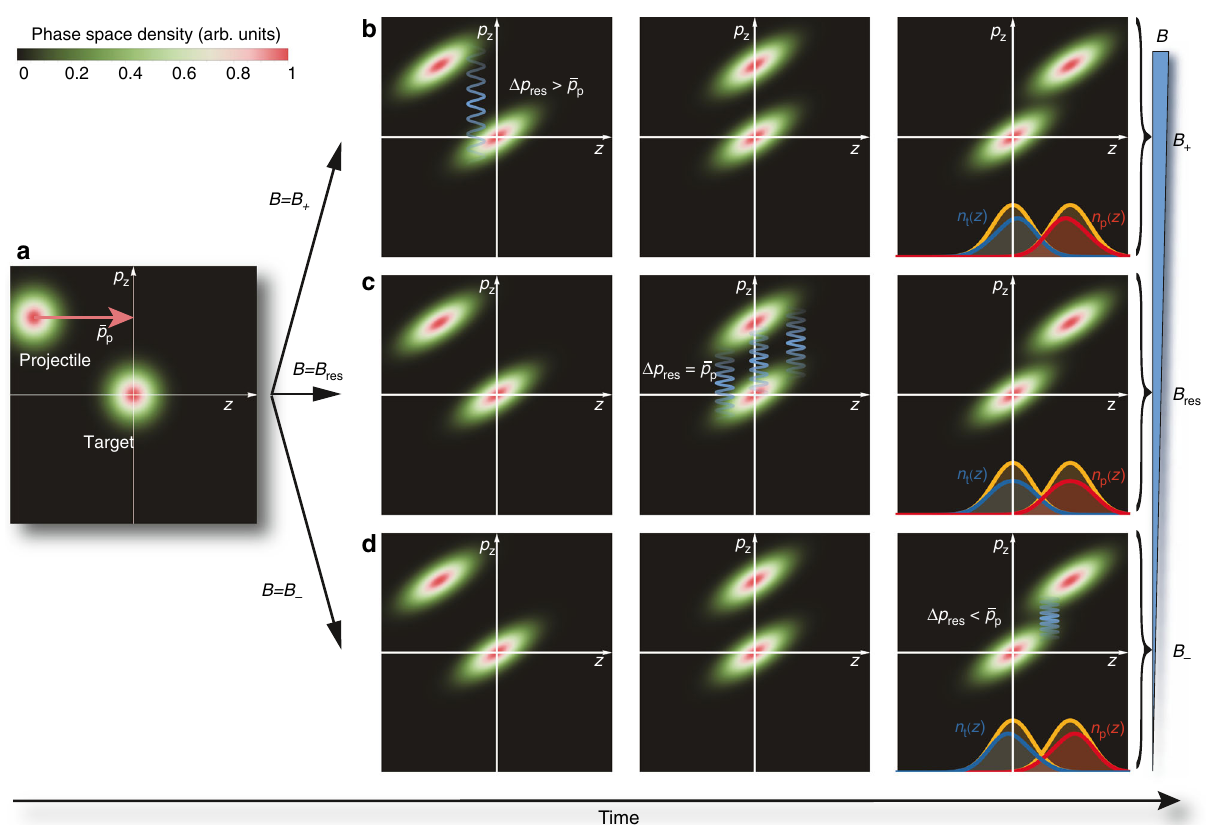
Fig. 4 Collisions between ballistically expanding projectile and target clouds. Phase-space representations of an ensemble of projectile atoms transiting a stationary target cloud subject to resonant Feshbach loss. Resonant interactions between groups of particles in the projectile and targets clouds are indicated by wavy blue lines and happen whenever a projectile particle arrives at the position of a target particle and their momentum difference is p p − p t = ffiffiffiffiffiffiffiffiffiffiffiffiffiffiffiffiffiffiffi p Δ p Δ p ð B Þ ¼ 4 mE res ð B Þ ; in particular, B res de fi nes the fi eld for which res . The actual value for the resonant momentum difference depends on B as res Δ p ¼ p — the mean momentum of the projectile cloud. a Target and projectile atoms are initially con fi ned by two harmonic potentials; the projectile res p cloud moves with a mean momentum p toward the target. By switching off the harmonic con fi nement, the atomic clouds expand ballistically before p colliding. b For a magnetic fi eld B = B + > B res , Δ p res > p and loss is resonantly enhanced at early times of the transit and occurs at the head-end of the p projectile cloud and the z < 0 part of the target. c For B = B res , Δ p res ¼ p (by de fi nition) and atoms with momentum difference equal to p will undergo p p resonant loss. This condition is ful fi lled uniformly throughout the clouds at the point in time where they coincide. d For B = B − < B res , Δ p res < p and resonant p collisions predominantly happen toward the end of the transit and lead to loss at the tail-end of the projectile cloud and the z > 0 part of the target. The rightmost frame of b – d shows how the marginal spatial density distributions n t ( z ) and n p ( z ) of the target cloud ( blue line ) and the projectile cloud ( red line ), respectively, distort from their shape in absence of resonant loss ( orange line